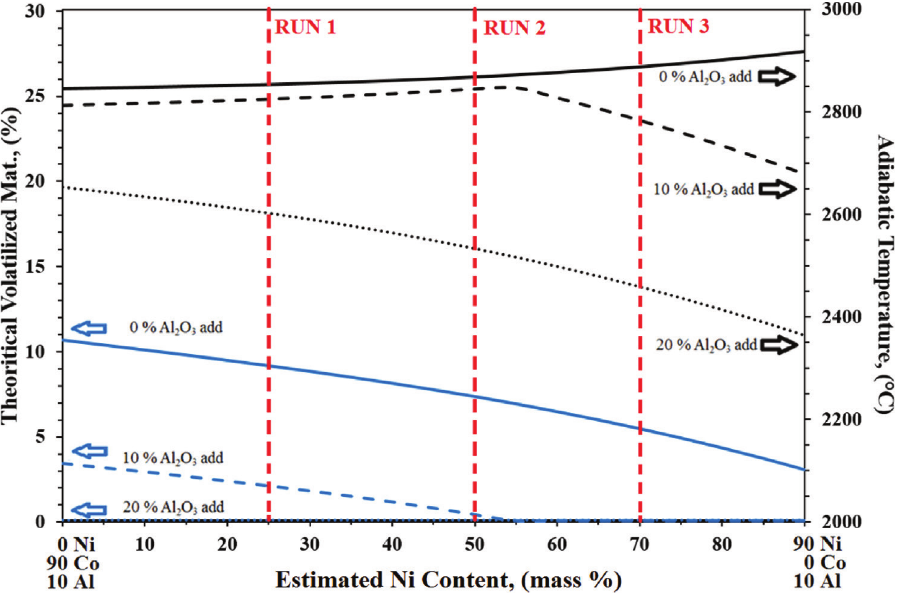
Fig. 3: Simulation results of the adiabatic temperature and estimated volatilized products changes with changing in Ni contents of final alloys while Al content fixed as 10 mass% [31]